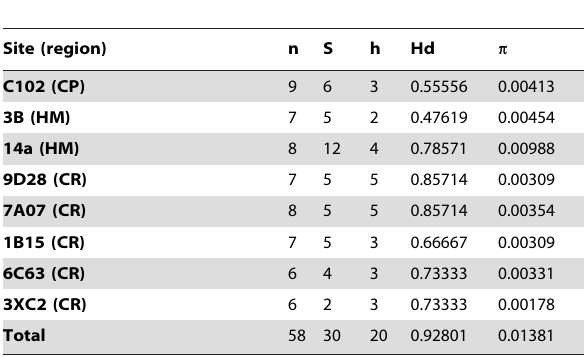
Table 4. Intra-population mt COI diversity statistics for the quill worm, Hyalinoecia longibranchiata